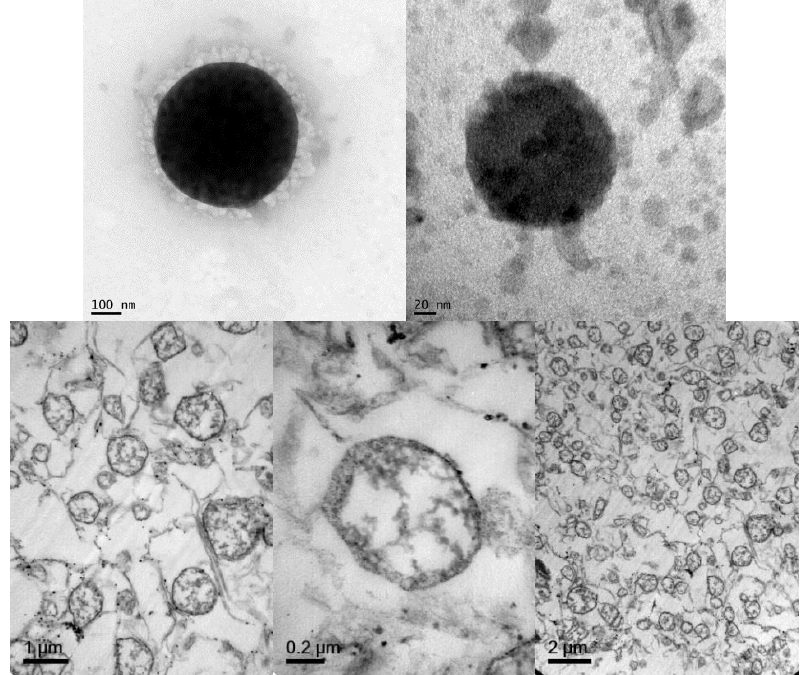
Figure 2. Representative TEM microphotographs of an NLC fixed with phosphor-tungstic acid ( top ) and sectioned with a microtome after lipid staining with osmium tetroxide and uranyl acetate ( bottom ).